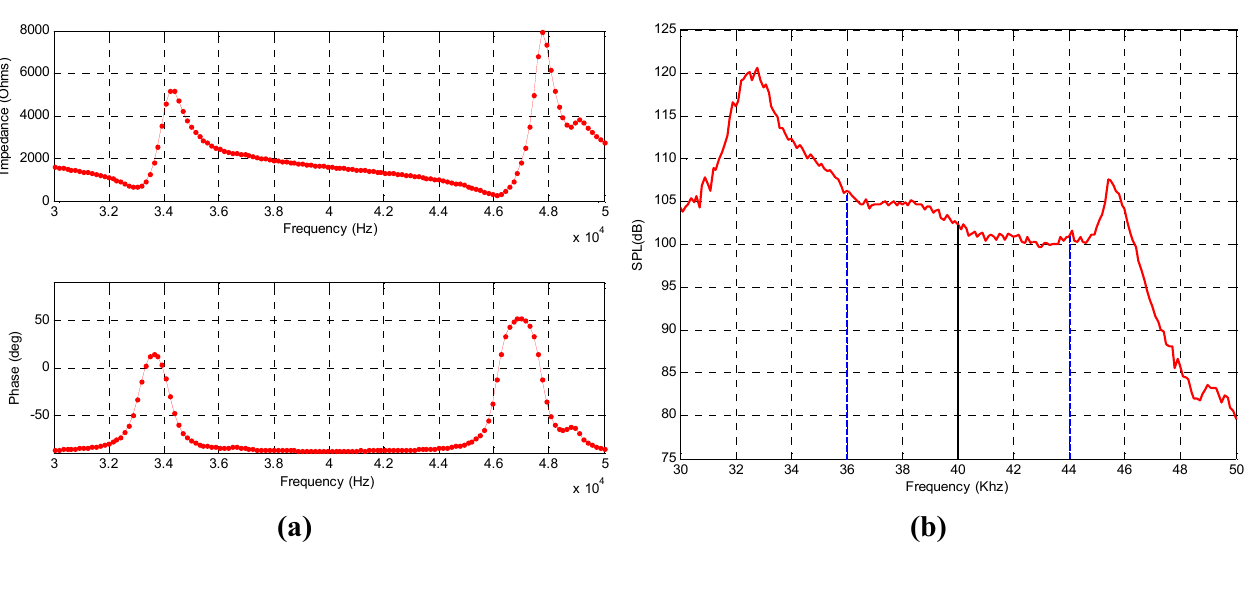
Figure 11. Measured 328ST160 transducer performance: (a) Impedance/Phase angle vs. frequency; (b) Sound pressure level (SPL) vs.